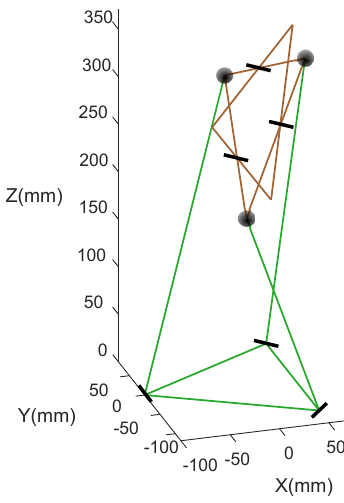
Figure 7. Singularity pose of Hybrid Mechanism 2.